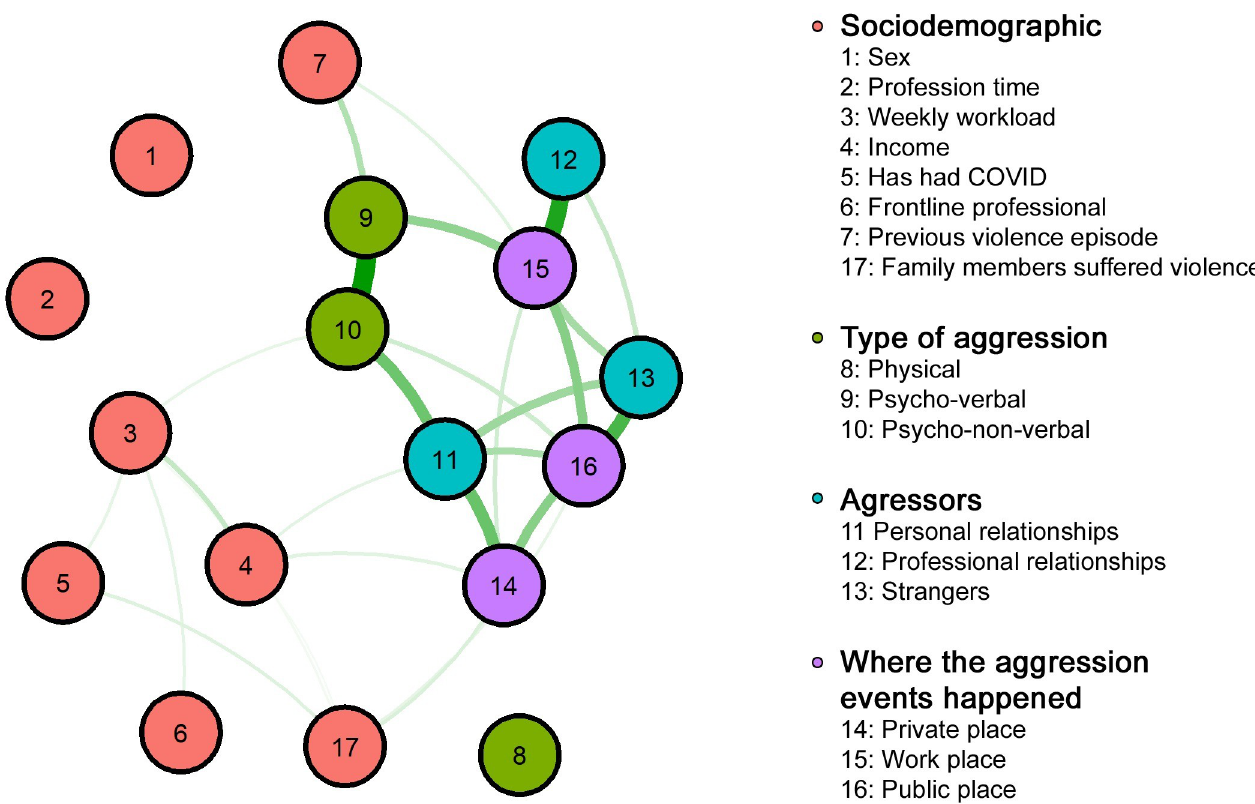
Fig 2. Association network among sociodemographic variables, types of aggression, aggressors, and the place where aggressions against health professionals occurred.